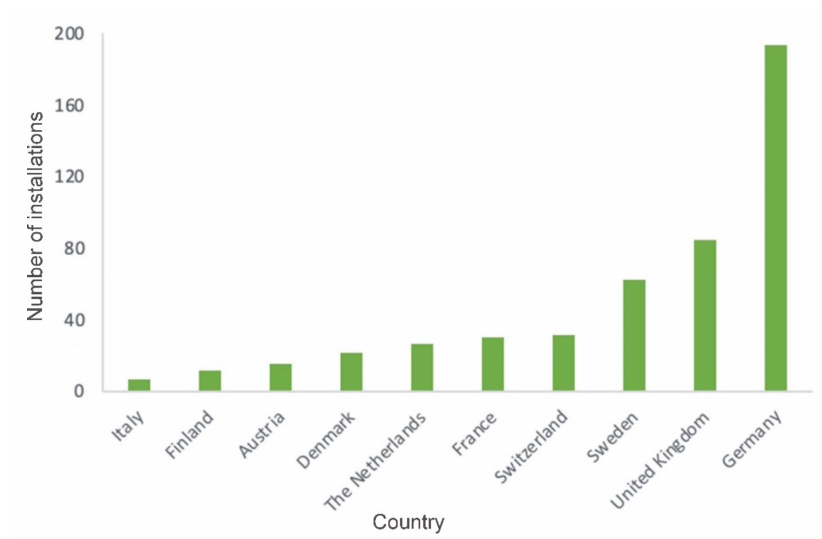
Figure 1. Production of biomethane (BM) in Europe; own elaboration based on